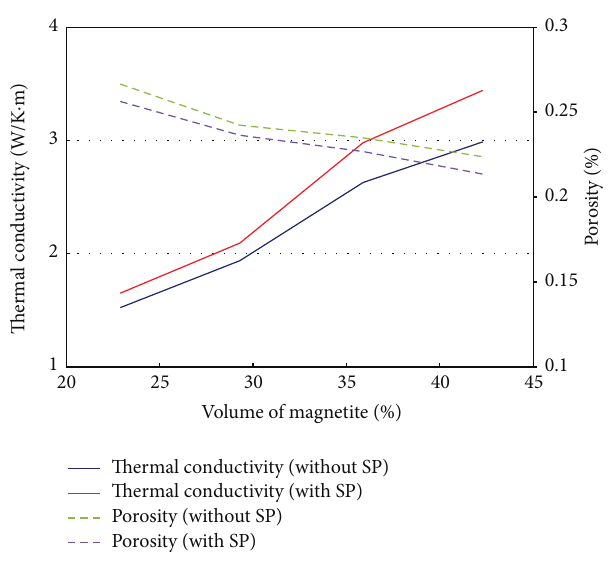
Figure 10: Thermal conductivity and reduced